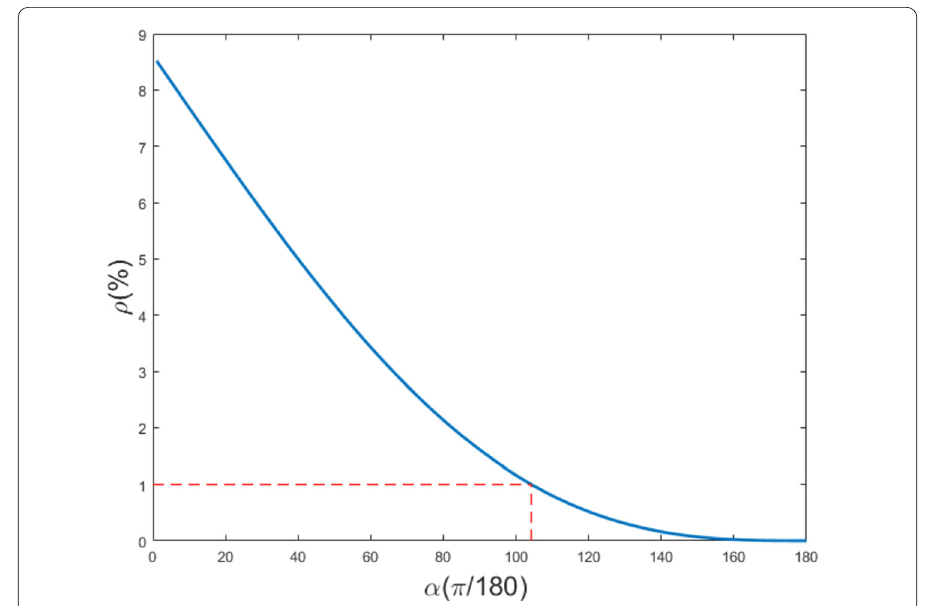
Figure 5 ρ and α changes between the